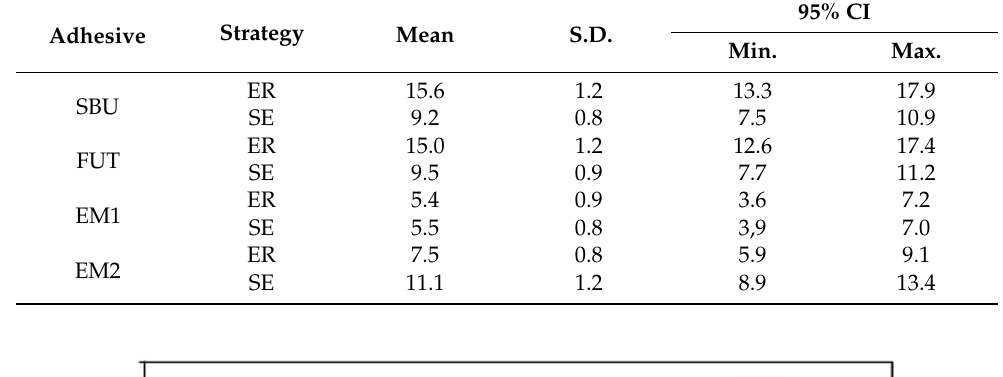
Table 8. Descriptive statistics for the mean results of nanoleakage (in %) for the different experi- mental groups, according to their adhesive strategy or application mode (ER/SE). CI represents con- fidence interval.